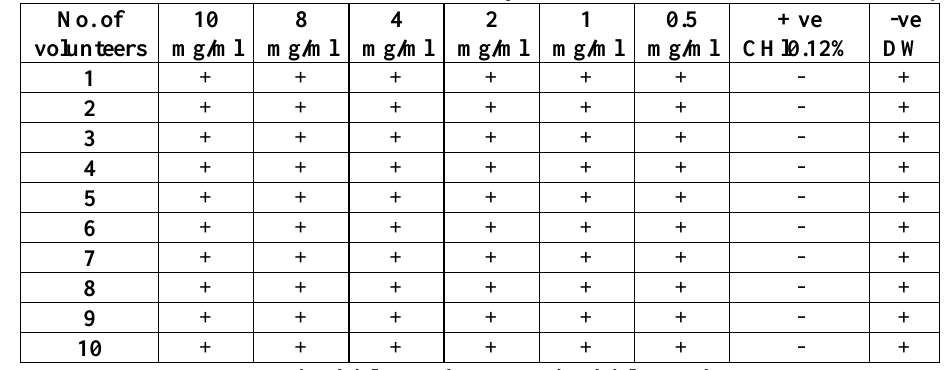
Table 1. Test Performance for Minimum Inhibitory Concentration (MIC) on Oral Streptococci No.